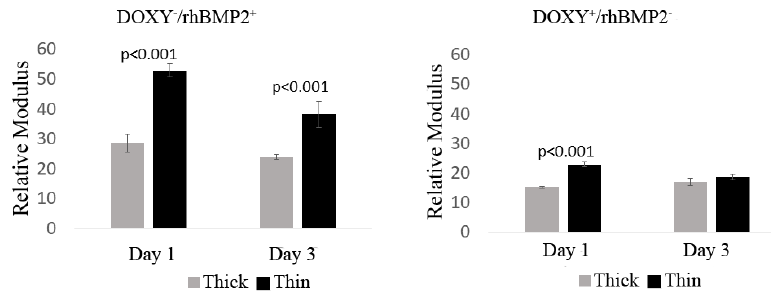
Figure 2. Comparison of relative moduli of C9 cells after 1- and 3-day incubation on 200 nm (gray) and 20 nm (black) PB films. Left : Cells overexpressing rhBMP2 + . Right : Cells where rhBMP2 − expression is suppressed.